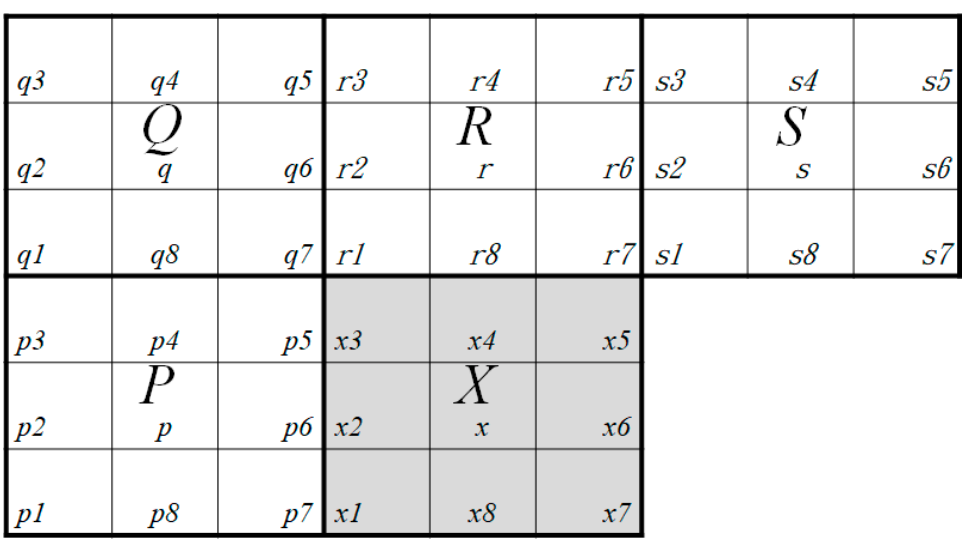
Figure 8. Block texture scan mask.